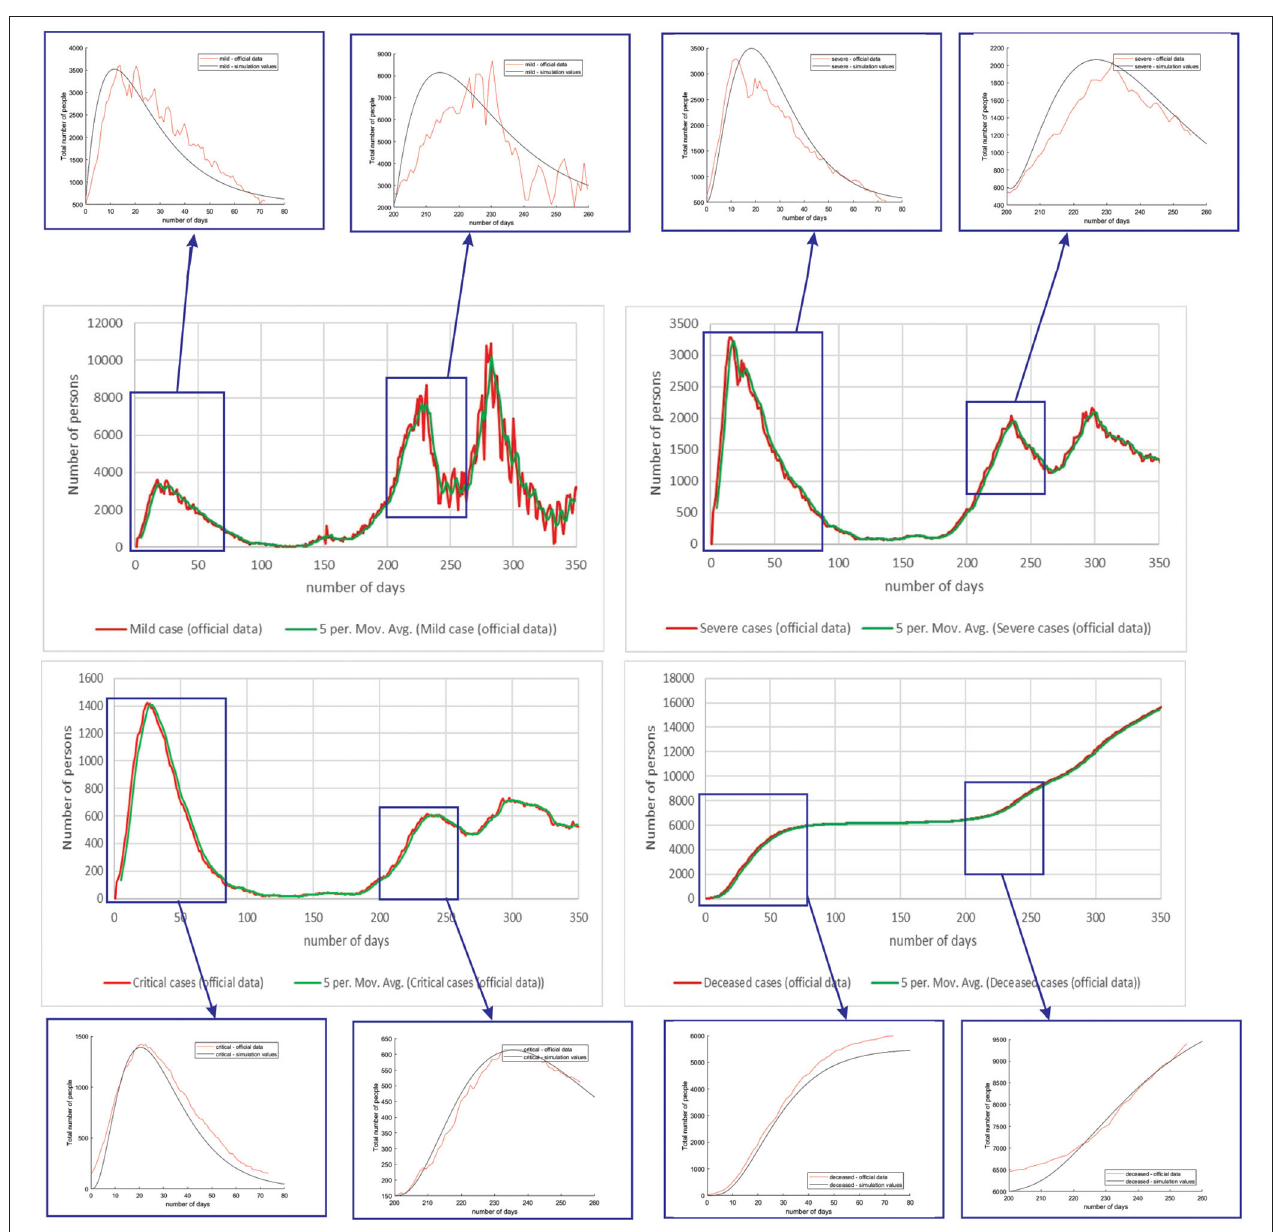
FIGURE 8 | Comparison of real and simulated values for the four categories of interest (Netherlands), mild infection, severe infection, critical infection, and deceased